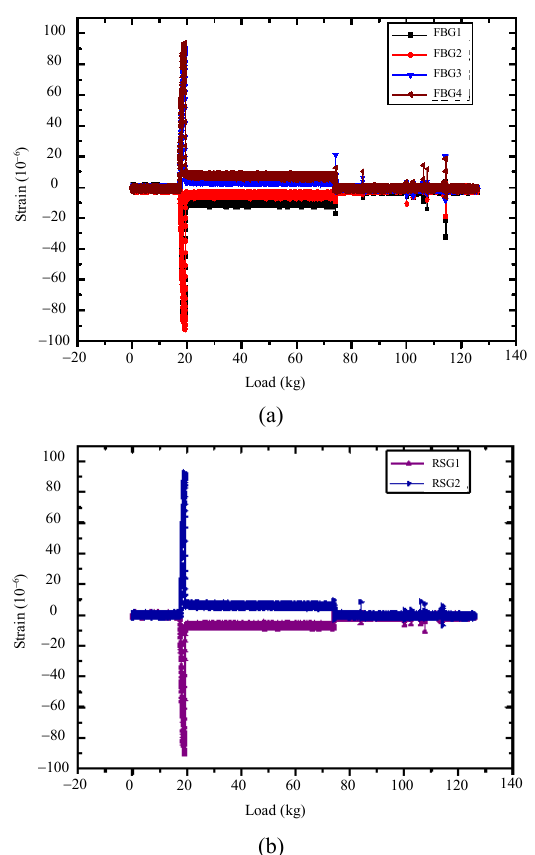
Fig. 10 Strain time travel curves under the impact load: (a) strain time travel curves measured by FBG sensors and (b) strain time travel curves measured by resistance strain